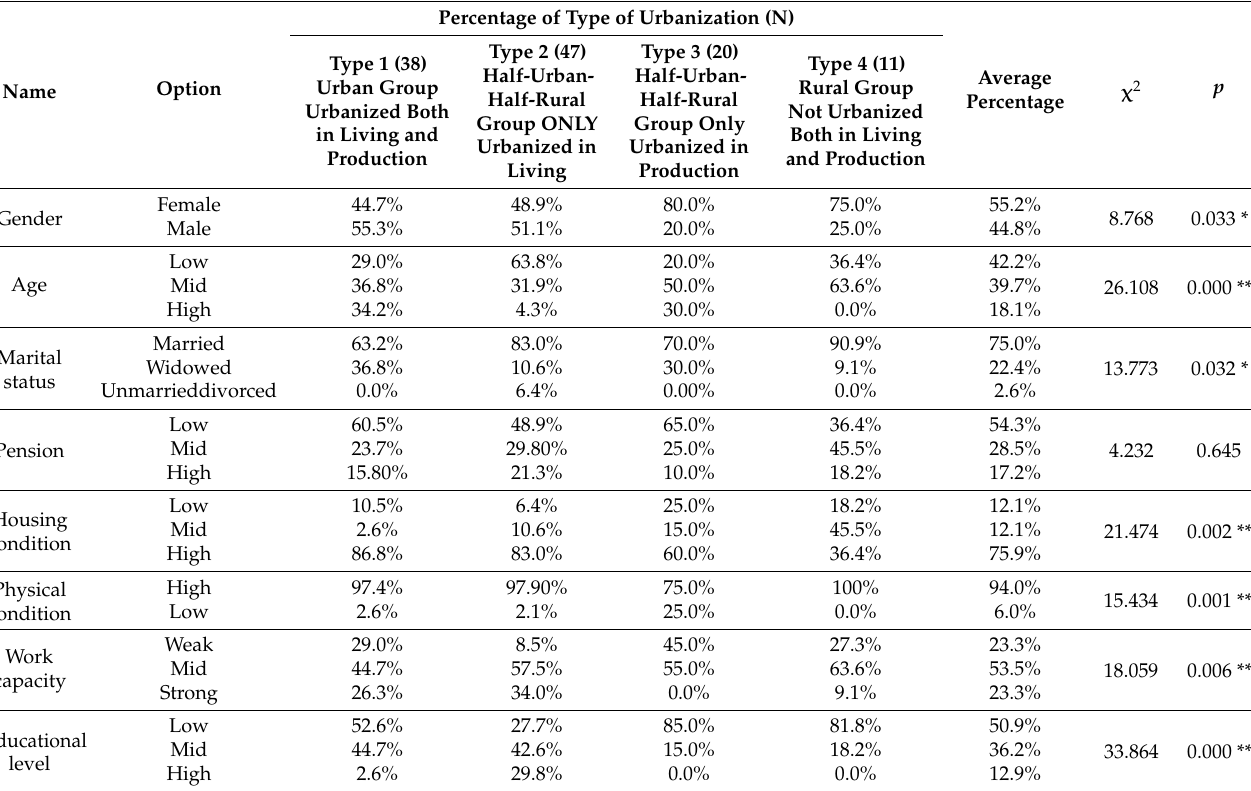
Table 5. Results of cross-sectional (chi-square) analysis of urbanization types and elderly migrants’ individual characteristics (Source: